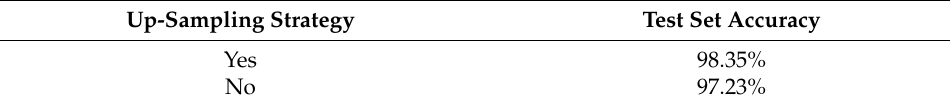
Figure 2. Percentage of different classes in FSD. Table 1. Effects of up-sampling on model accuracy.